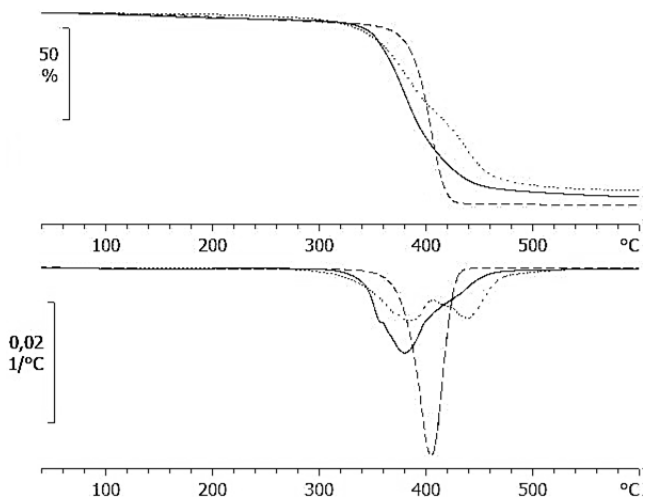
Figure 3. Comparative thermogravimetric results for the epoxy (dotted line), HBPEI (dashed line) and ELP (full line), for a heating rate of 10 K/min: upper graph, % weight loss as a function of temperature; lower graph, differential thermogravimetric analysis (DTGA) curves.